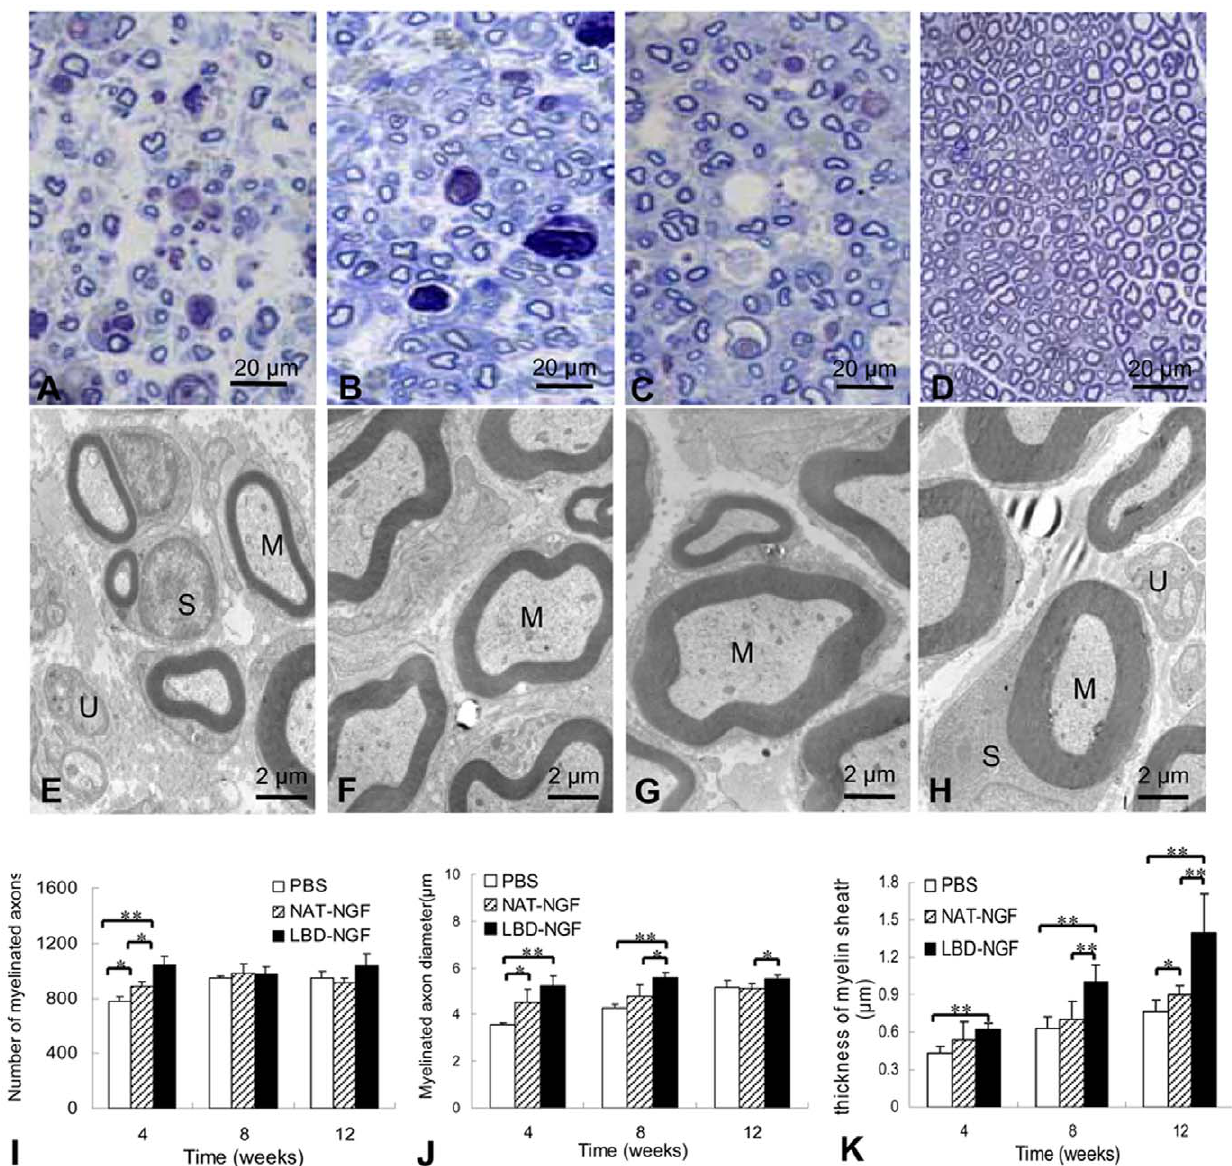
Figure 6. Remyelination of sciatic nerves. (a–d) Toluidine blue staining. At week 4 after injury, light micrographs of transverse semi-thin sections at the injury sites of the control (a), NAT-NGF (b) and LBD-NGF group (c) compared with that of native nerve group (d). (e–h) Transmission electron micrographs (TEMs). At week 12 after injury, ultra-thin sections at the injury sites of the control (a), NAT-NGF (b) and LBD-NGF group (c) compared with that of native nerve group (d) were observed under TEM. (i) The statistical analysis of the number of myelinated axons. (j) The statistical analysis of the myelinated axon diameter. (k) The statistical analysis of thickness of myelin sheath. Myelinated axons (M), unmyelinated axons (U) and Schwann cells (S) surrounding the myelinated axons can be seen clearly. n=6, *, P , 0.05, **, P , 0.01, determined by two-tailed student’s t